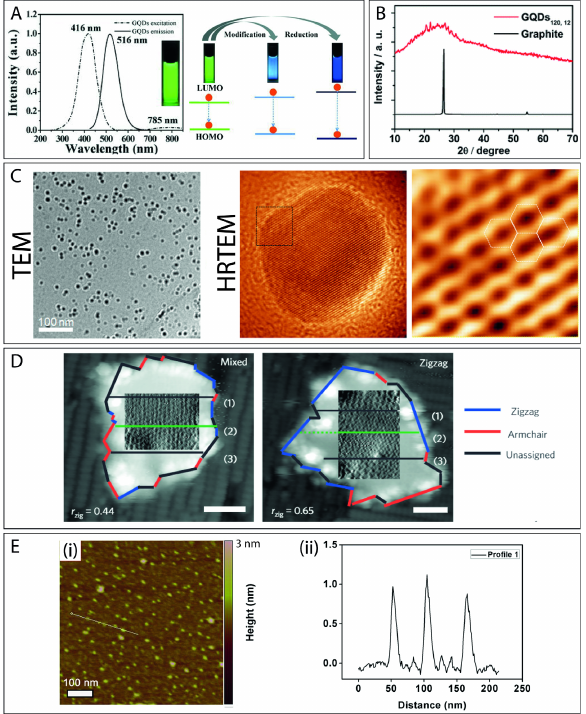
Figure 3. ( A ) Excitation (dashed line) and emission (solid line) photoluminescence spectra of GQDs and a schematic illustration of the bandgap changing of GQDs with different surface defects. Repro- duced with permission from reference [121]. Copyright 2012 Wiley. ( B ) XRD patterns of graphite and GQDs 120,12 (obtained at 120 ◦ C in a 12 h synthesis). Adapted with permission from reference [48]. Copy- right 2013 The Royal Society of Chemistry. ( C ) TEM images for GOQDs and HRTEM images of single GOQDs. Reproduced with permission from reference [126]. Copyrights 2020 Wiley. ( D ) Determination of the edge types of the GQDs by STM analysis. The values of 0.65 and 0.44 are ascribed to the fraction of zigzag edges. Scale bars = 2 nm. Reproduced with permission from reference [129]. Copyright 2009 Nature. ( E ) ( i ) AFM images of GQDs and ( ii ) the resulted height profile of the GQDs. Reproduced with permission from reference [130]. Copyright 2017